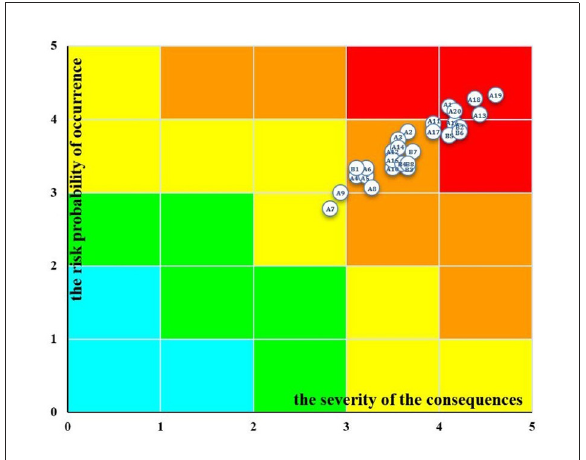
FIGURE1 Prehospital delay risk matrix map of stroke. There are five colors in the risk matrix diagram that represent different degrees of risk and corresponding processing methods. Blue corresponds to very low risk (I), green corresponds to low risk (II), yellow corresponds to medium risk (III),orange corresponds to high risk (IV), and red corresponds to very high risk